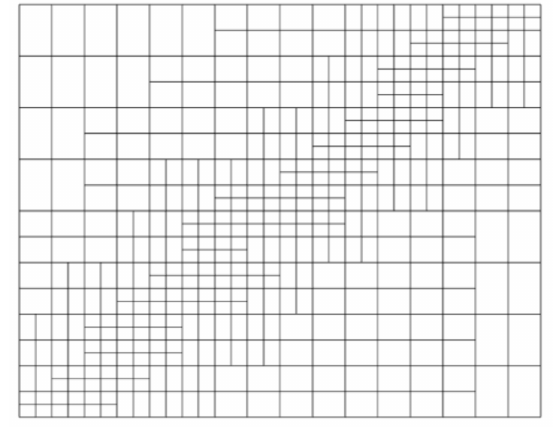
Figure 7. T-mesh of the reference